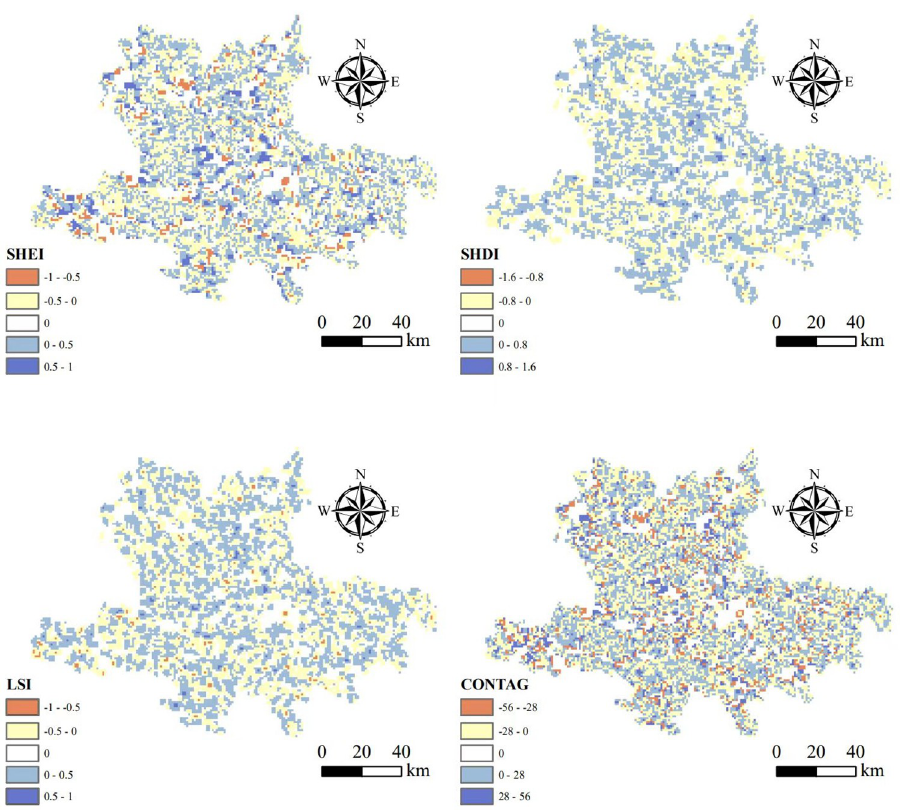
Fig 3. Spatial change of landscape index in Hani area between 1990 and 2020. https://doi.org/10.1371/journal.pone.0283142.g003 After calculating the average values of SHDI, SHEI, LSI, and CONTAG indexes for the 2 km and 4 km buffer zones around traditional ethnic villages (Table 2), from 1995–2020, the SHDI, SHEI and LSI indexes for the 2km buffer zone were significantly lower than for the